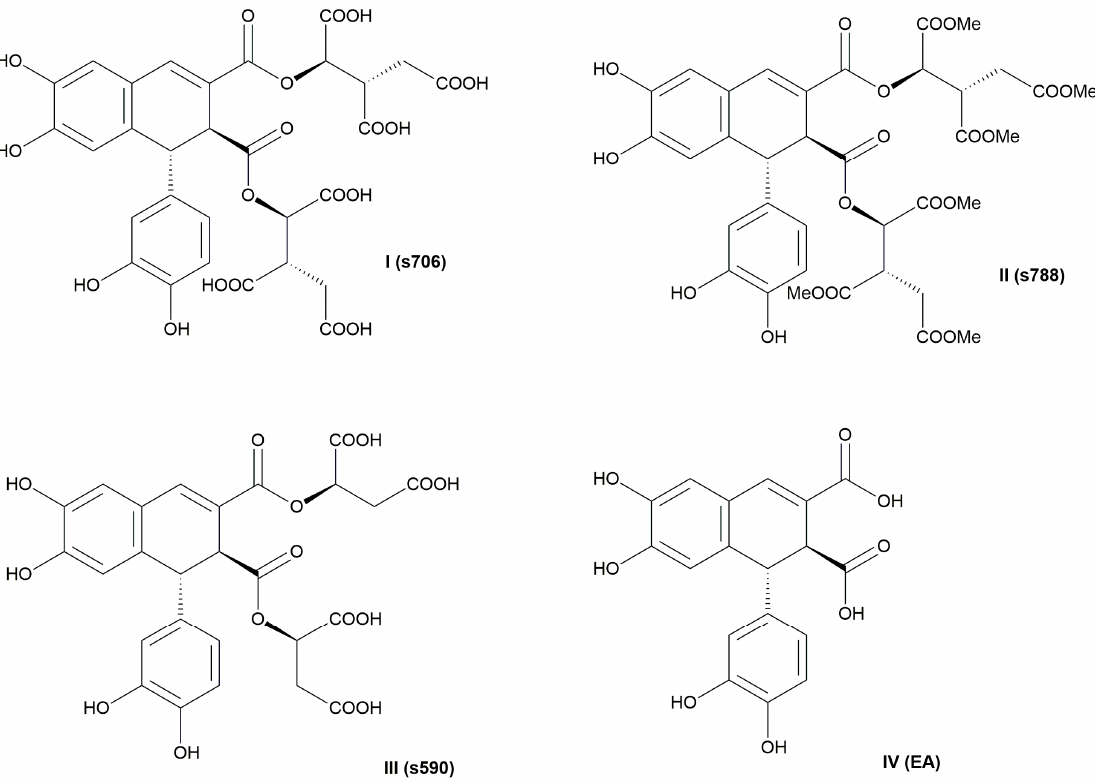
Figure 1. Sevanol and its analogues: I —sevanol; II —sevanol with methylated carboxylic groups; III —sevanol shortened by two acetic acid groups; IV —epiphyllic acid.